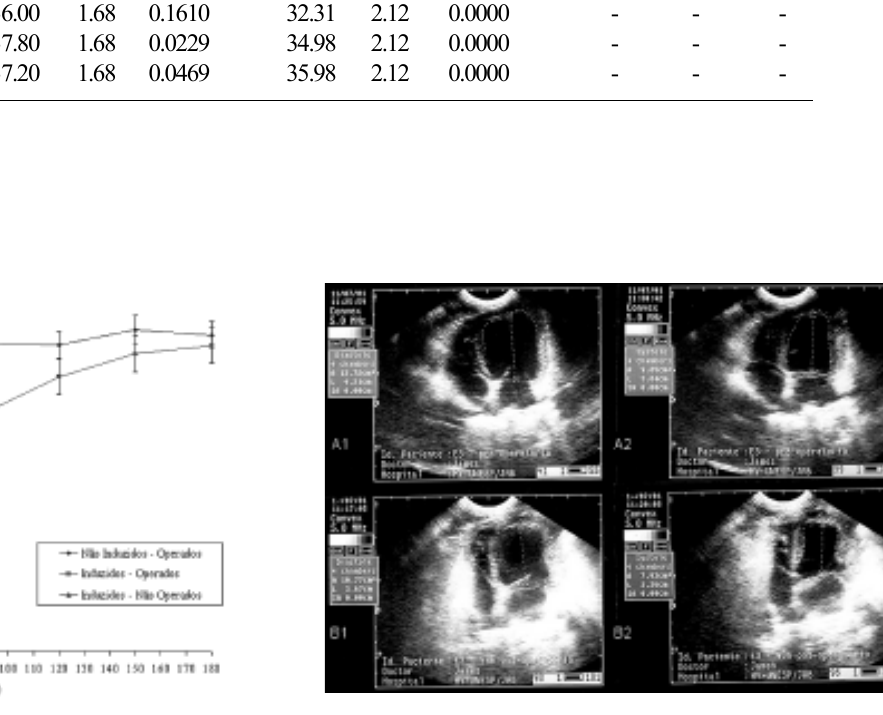
Fig. 3 – Ecocardiograma em modo bidimensional, vista apical esquerda (quatro câmaras) em diástole (1) e sístole (2), de cão com cardiomiopatia dilatada induzida pela doxorrubicina, 24 horas antes (A) e 48 horas após plicatura da parede livre do ventrículo esquerdo